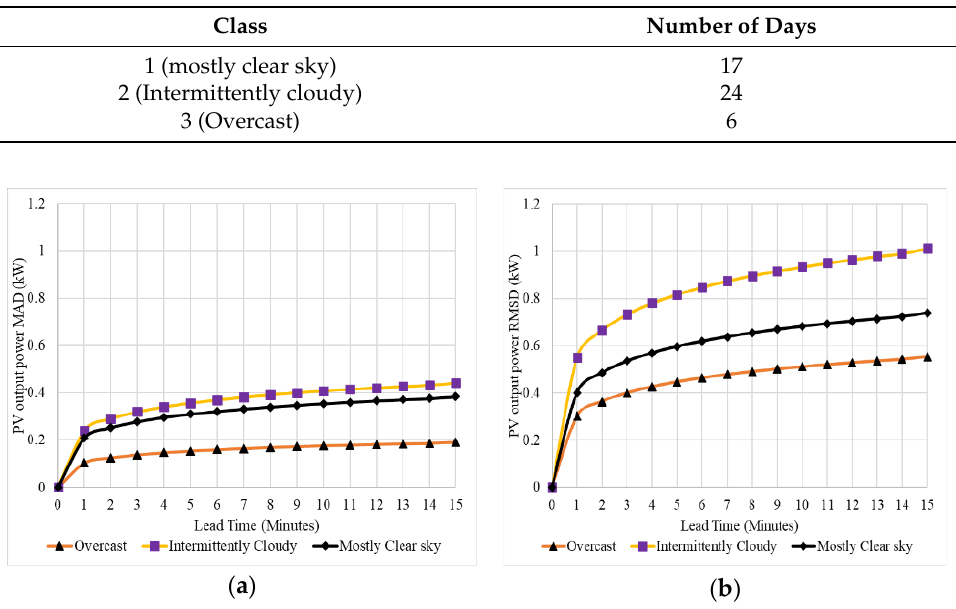
Figure 11. ( a ) PV output power MADs for the three classes. ( b ) PV output power RMSDs for the three classes.